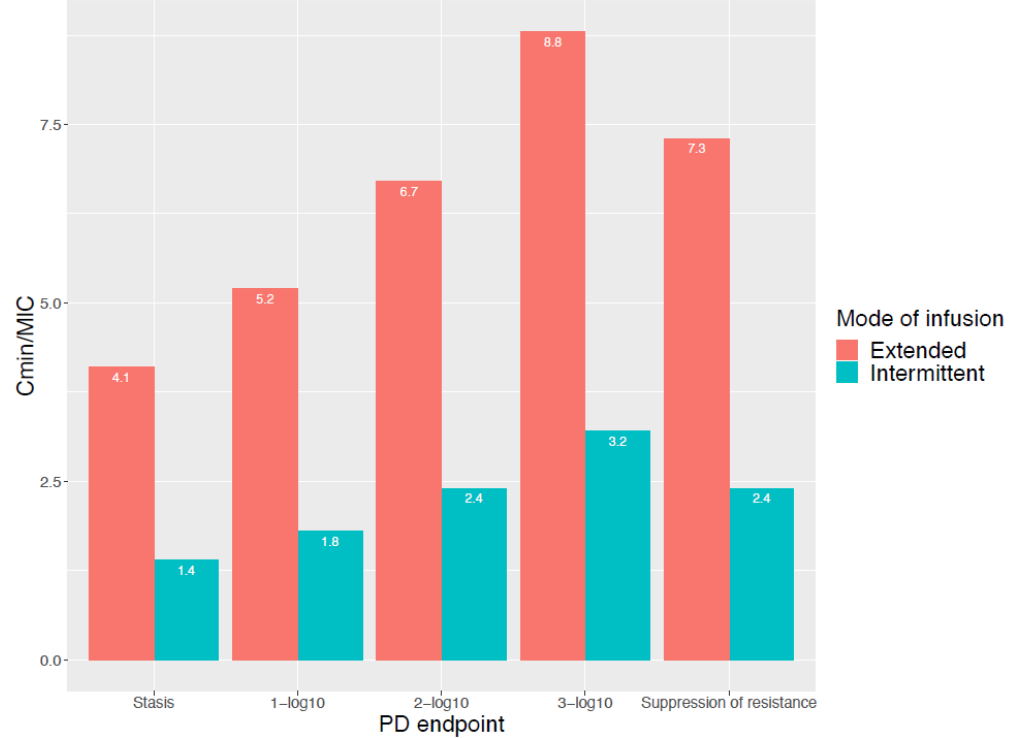
Figure 2. C min /MIC ratio for different PD endpoints and for both intermittent and extended infusion. Reproduced from Felton et al. [29] .